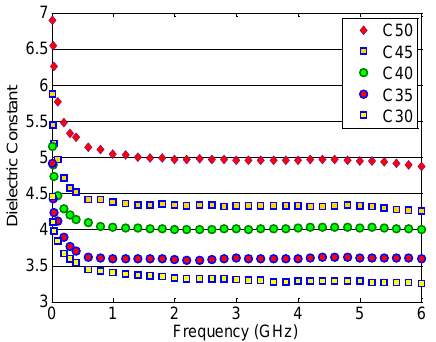
Figure 4. Measured average compressive strength and standard deviation versus w / c ratio.